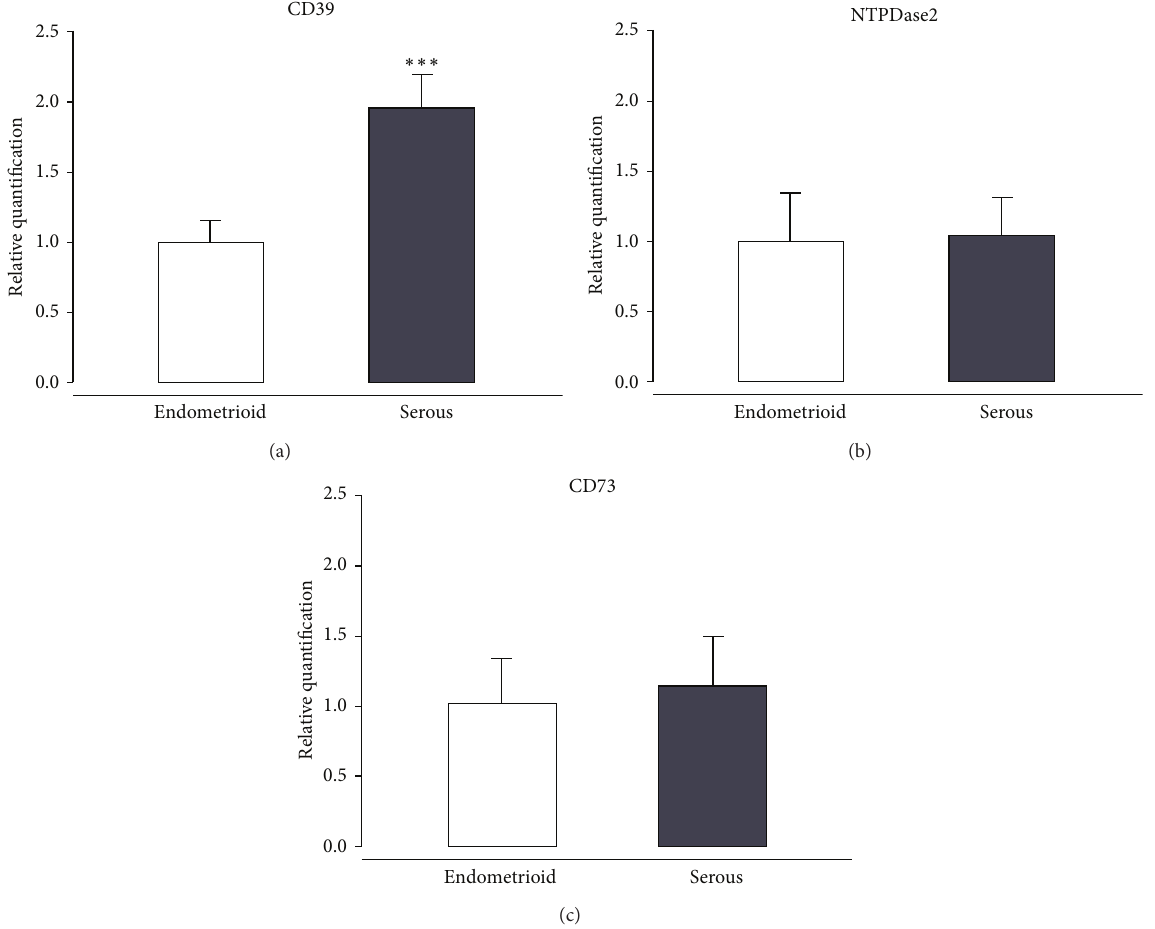
Figure 4: CD39 , NTPDase2, and CD73 gene expression in human endometrial cancer tissues. Relative mRNA levels of CD39 (a), NTPDase2 (b), and CD73 (c) analyzed in serous adenocarcinomas ( 𝑛 = 7 ), normalized to 18S mRNA levels, and expressed as fold change over endometrioid adenocarcinomas ( 𝑛 = 7 ). Data are expressed as mean ± SEM. ∗∗∗ Significantly different from endometrioid ( 𝑃 < 0.001